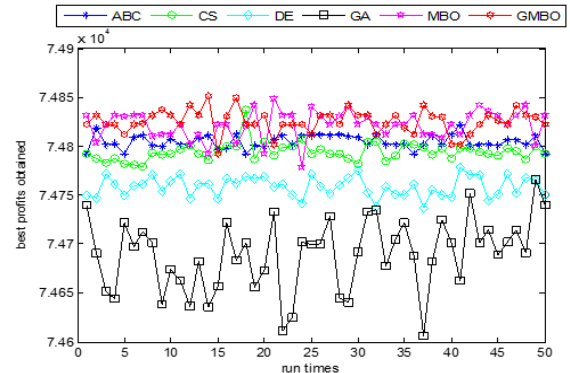
Figure 11. Comparison of the best values on KP14 in 50 runs.